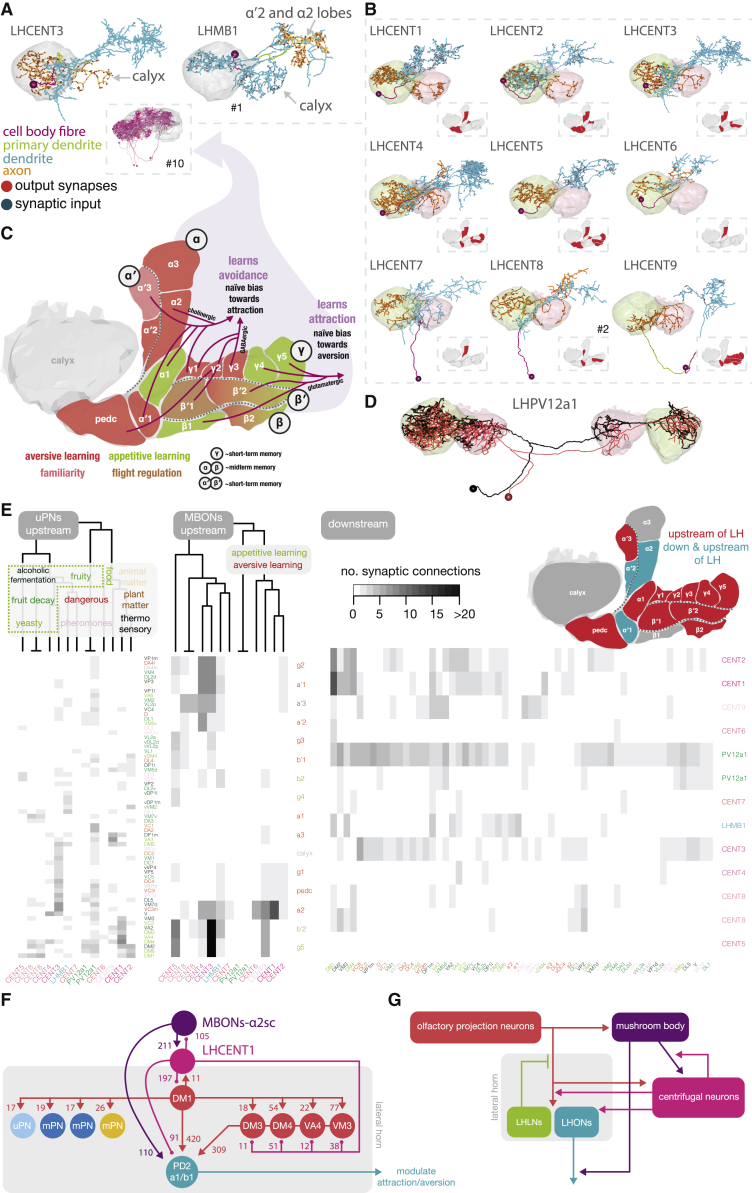
Feedback Memory Input to the LH(A) Left, an example of an LH centrifugal neuron. Inset, all neurons of the class shown in purple hues. Right, LHMB1, a single LHON that targets the MB lobes.(B) 10 LH centrifugal neurons form 9 cell types. Insets depict the MB compartments, whose MBONs innervate LHCENT neurons.(C) Diagram of the MB lobes, colored by putative valence [3, 11].(D) FAFB EM reconstruction of a large bilateral interneuron, LHPV12a1 [14] that connects both CAs and LHs (black) and its light-level match from a recent split-GAL4 screen (red).(E) Heatmaps showing the connectivity of uPNs→MB-LH neurons (left), MBONs→MB-LH neurons (middle) by compartment and, conversely MB-LH neurons→uPN axons and MB-LH neurons→MBON dendrites (right). PN and MB compartment names colored by odor scene and valence respectively. If a PN falls into more than one odor scene, only one color is chosen.(F) Example with synaptic weights of how memory can control or modulate lateral horn neurons known to be important for aversive memory recall [14] (arrows = acetylcholine; circles = transmitter unknown).(G) Schematic depicting how MBONs interact with LHNs via LH centrifugal neurons. Arrows can be of inhibitory, excitatory or unknown sign.See also Figures S6 and S7; Data S1 and S4.